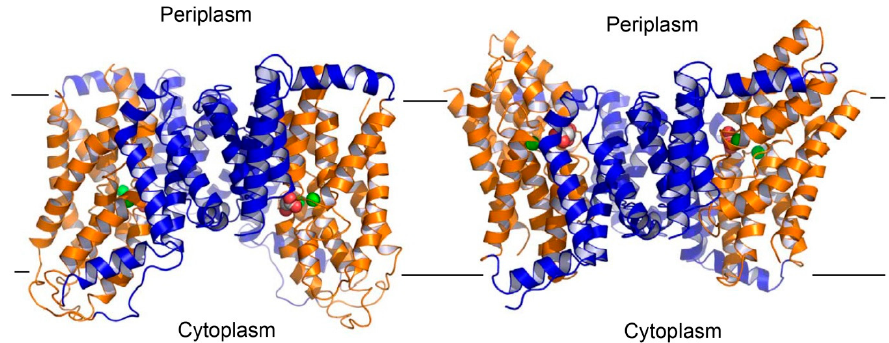
Figure 8. Structural model of the outward-facing VcINDY. Structure of the inward-facing VcINDY as viewed from the membrane bilayer ( left panel ). VcINDY is drawn as a ribbon diagram, with its scaffold (residues 18-128, 250-357) and transport (residues 129-249, 358-462) domains colored blue and orange, respectively. Na + ions (green) and succinate are shown as spheres. The structural model of the outward-facing VcINDY ( right panel ). The orientation and coloring scheme are both the same as in panel A. As the transport domain traverses the membrane, VcINDY alternates between the inward- and outward-facing conformations.